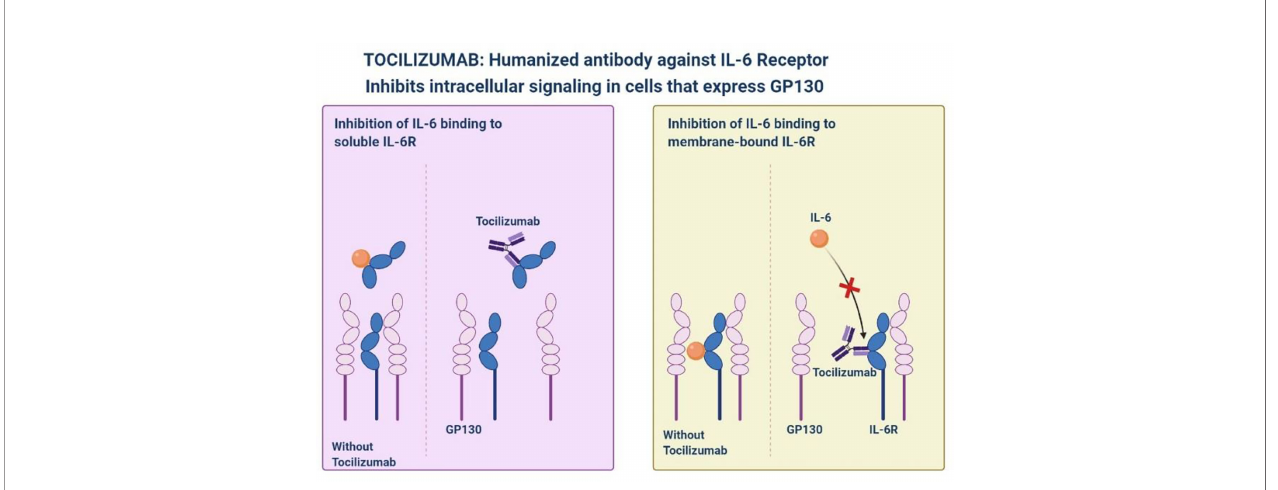
FIGURE 2 | Inhibition of intracellular signaling by Tocilizumab Humanized Antibody against